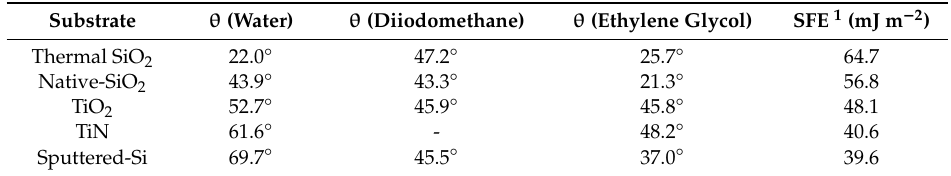
Table 1. Average values of contact angles of three solvents in different substrates, and SFE values determined for each substrate.